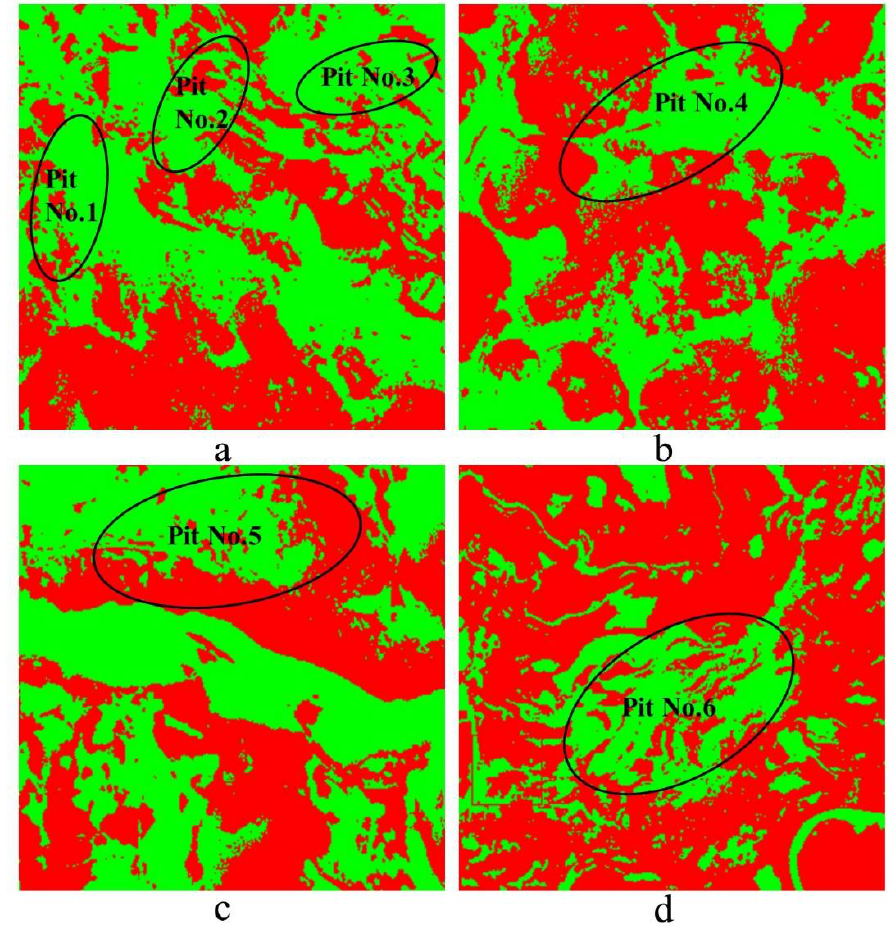
Figure 26. Pit on the areas a – d . Table 3. Area (a).